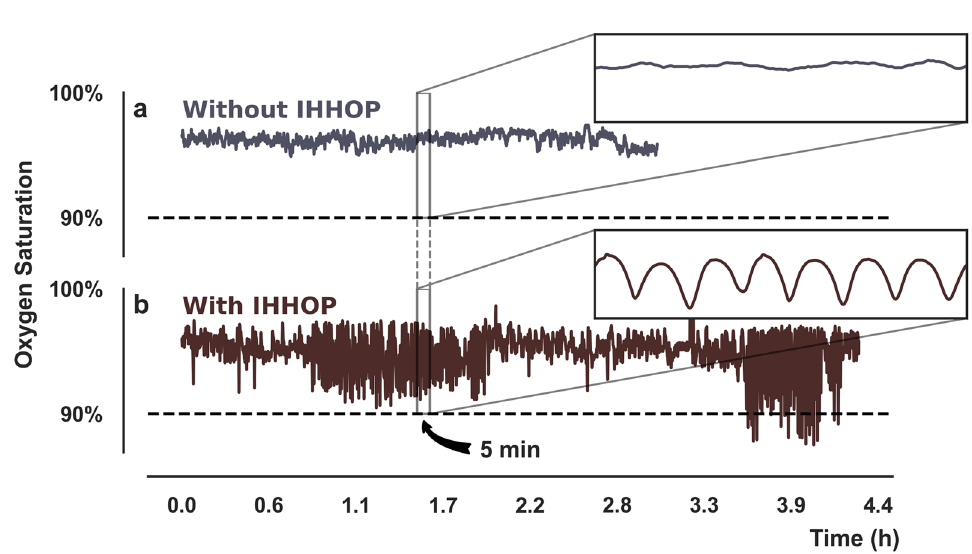
Figure 1. Illustrative arterial oxygen saturation time series from patients without intradialytic high-frequency and high-amplitude oximetry patterns (IHHOP) ( a ), and with IHHOP ( b ). The insets show 5 min segments of both time series. The dashed line marks the 90% oxygen saturation level, below which the patient is